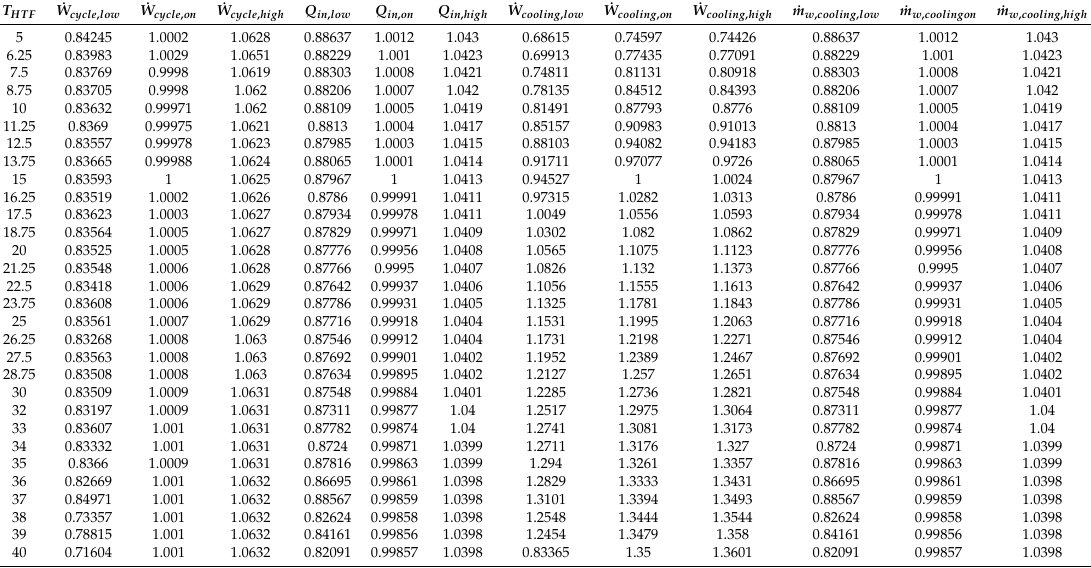
Table A3. Performance as a function of ambient temperature (MOD3) table for Allam cycle. “Low”, “On” and “High” respectively refer to the three values of molten salt (hot) temperature levels employed: 700, 770 and 800 ºC.